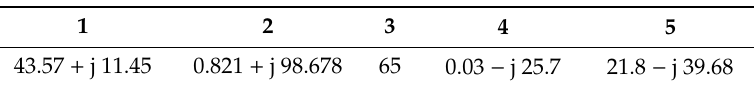
Table 1. Calibration Standards ( Ω ).